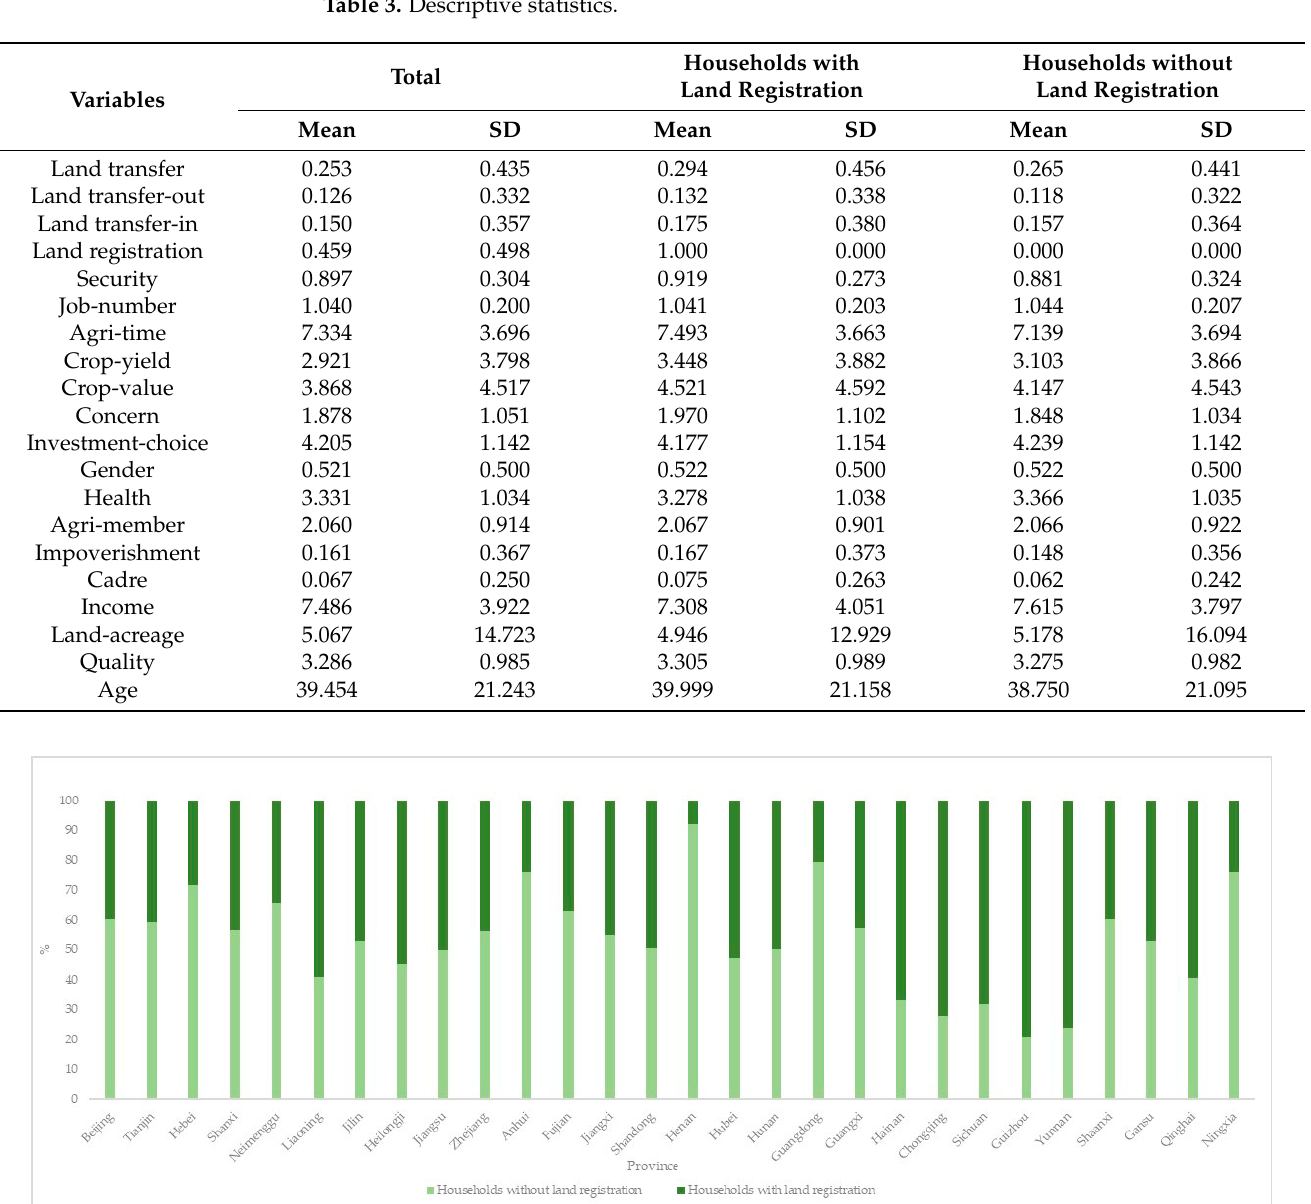
Figure 6. The relationship between households’ land registration and land transfer in rural China. Through the above descriptive statistics, it can be found that the proportion of households with land transfer is not high, and nearly half of them have officially registered the land contracting and management rights. The main reason why farmers transfer their land out is the migration of family labor to non ‐ agricultural occupations. Moreover, the main reason why individual farmers or organizations transfer land in is to obtain higher agricultural returns. The exact quantitative relationship between land registration and land transfer and whether there is a logical relationship will be further discussed later. 4.2. Empirical Results 4.2.1. The Impacts of the Land Registration Program on Land Transfer Table 4 examines H1, namely, whether the land registration program increases land transfer, including transfer ‐ out and transfer ‐ in. The models (1–3) in Table 4 show that under the control of other conditions, the regression coefficients of land registration are all significantly positive at the 5% level. In addition, specifically, the chances of land transfer, land transfer ‐ out, and land transfer ‐ in with land registration increase by 24.7%, 37.1%, and 18.1%, respectively, compared with those without land registration. This indicates that the land registration program has a positive impact on land transfer, including transfer ‐ out and transfer ‐ in. Namely, on the one hand, under the premise that the land registration program increases the security perception of the land supply party,